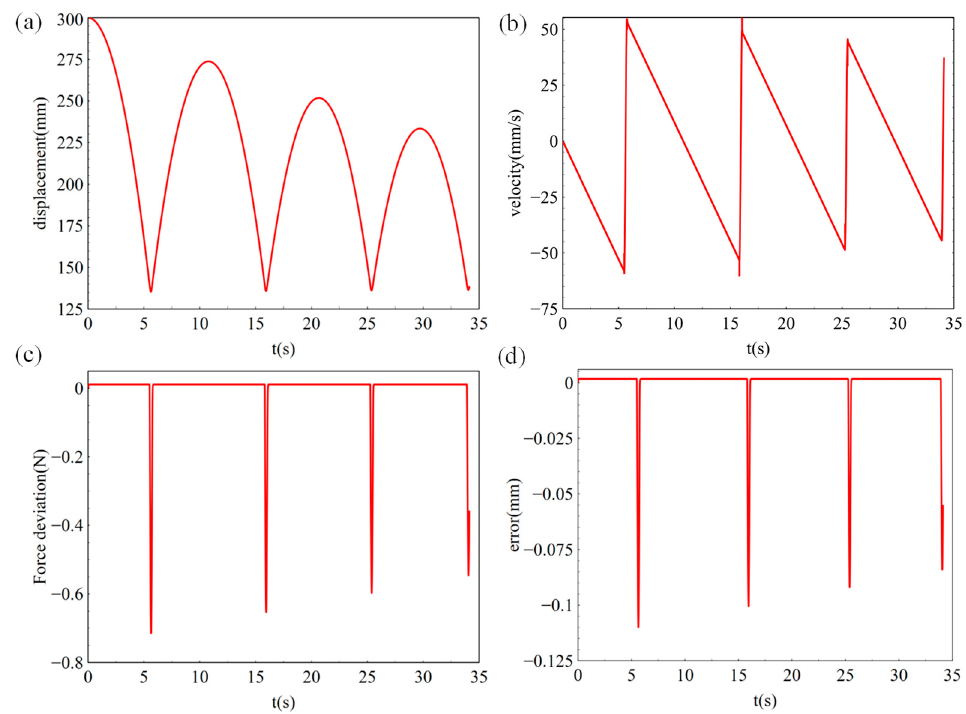
Figure 10. Simulation results of the landing buffer tests with input force of 0.98 N. ( a ) re-displacement curve, ( b ) velocity curve, ( c ) force deviation, ( d ) following error.